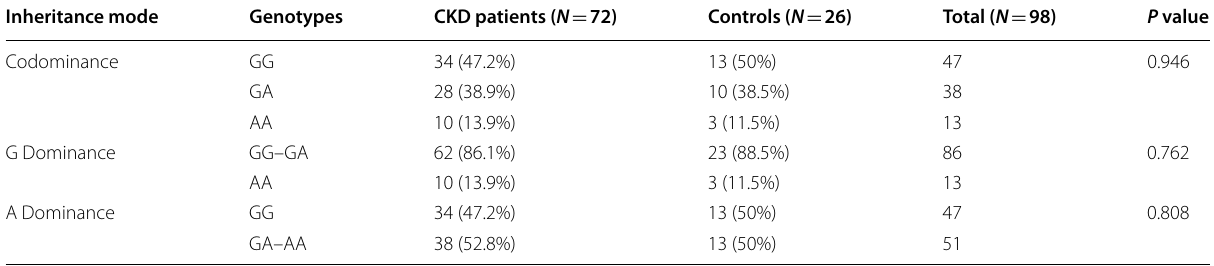
CKD, chronic kidney disease; FGF23, fibroblast growth factor 23